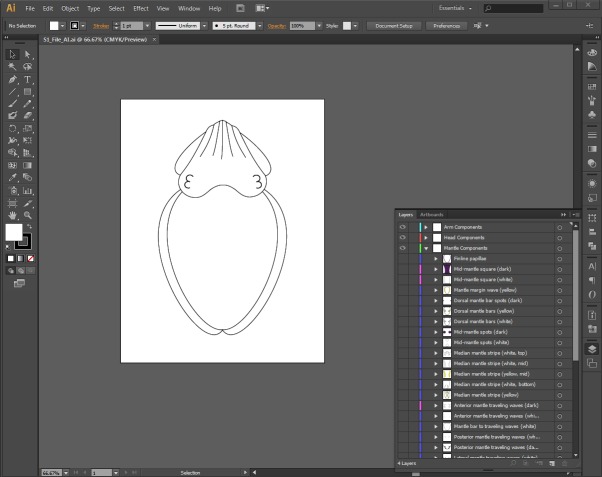
Screenshot of the interactive database for Metasepia pfefferi body patterning components.A screenshot of the interactive database created in Adobe Illustrator® CS6 for Metasepia pfefferi body patterning components. On the right, the ‘layers’ panel is visible with Arm, Head and Mantle components which can each be made visible to recreate any observed body pattern. This database is available both as an Adobe PDF (File S1) and an editable Adobe Illustrator file (10.6084/m9.figshare.1509930).